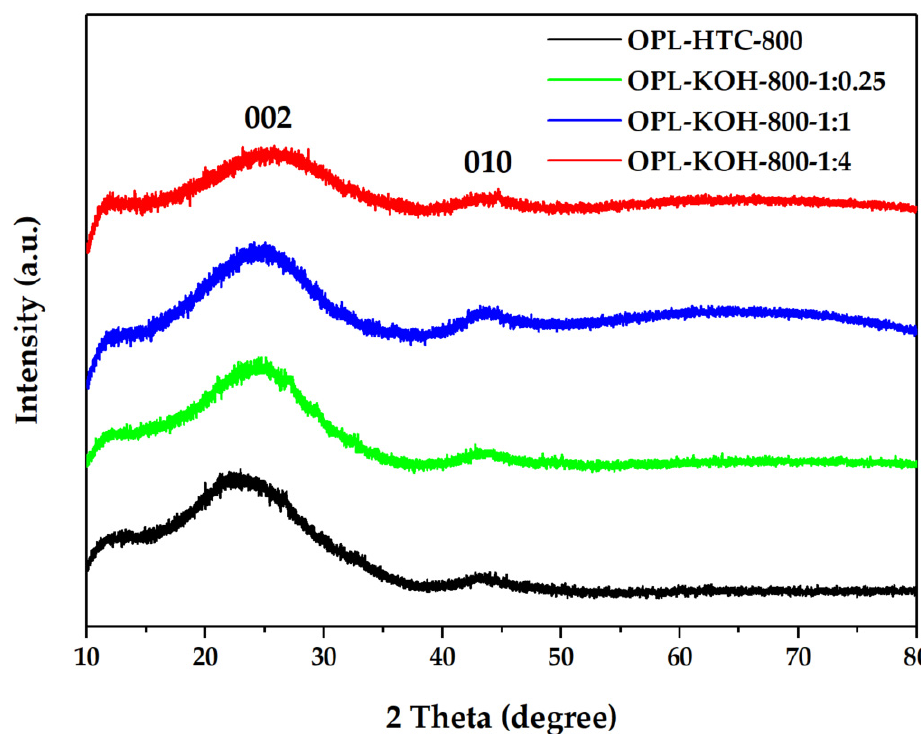
Figure 5. XRD patterns of OPL − HTC − 800, OPL − KOH − 800 − 1:0.25, OPL − KOH − 800 − 1:1, and OPL − KOH − 800 − 1:4.